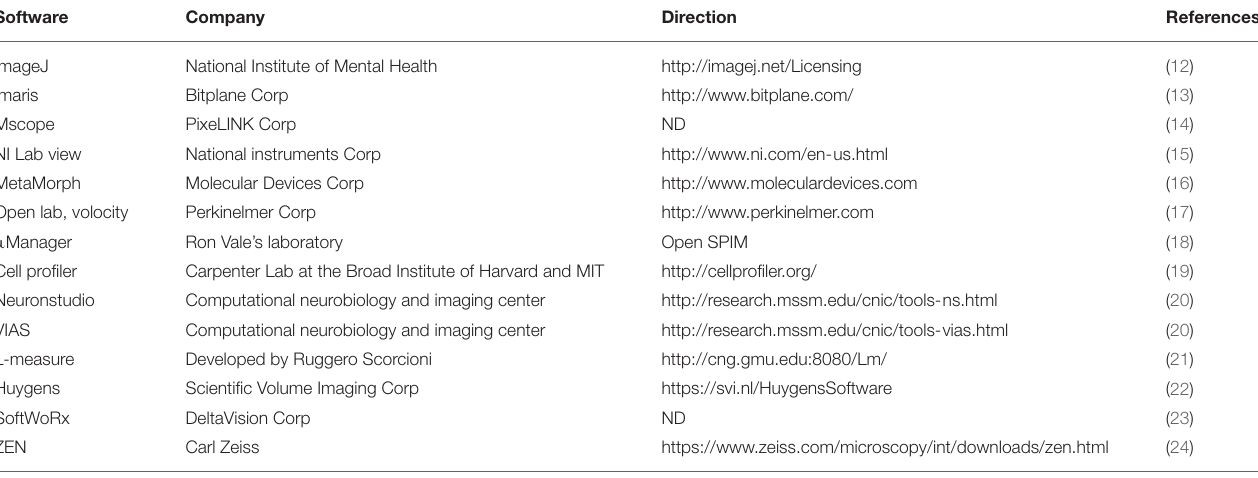
TABLE 1 | Computer software programs for three-dimensional reconstruction of image series.